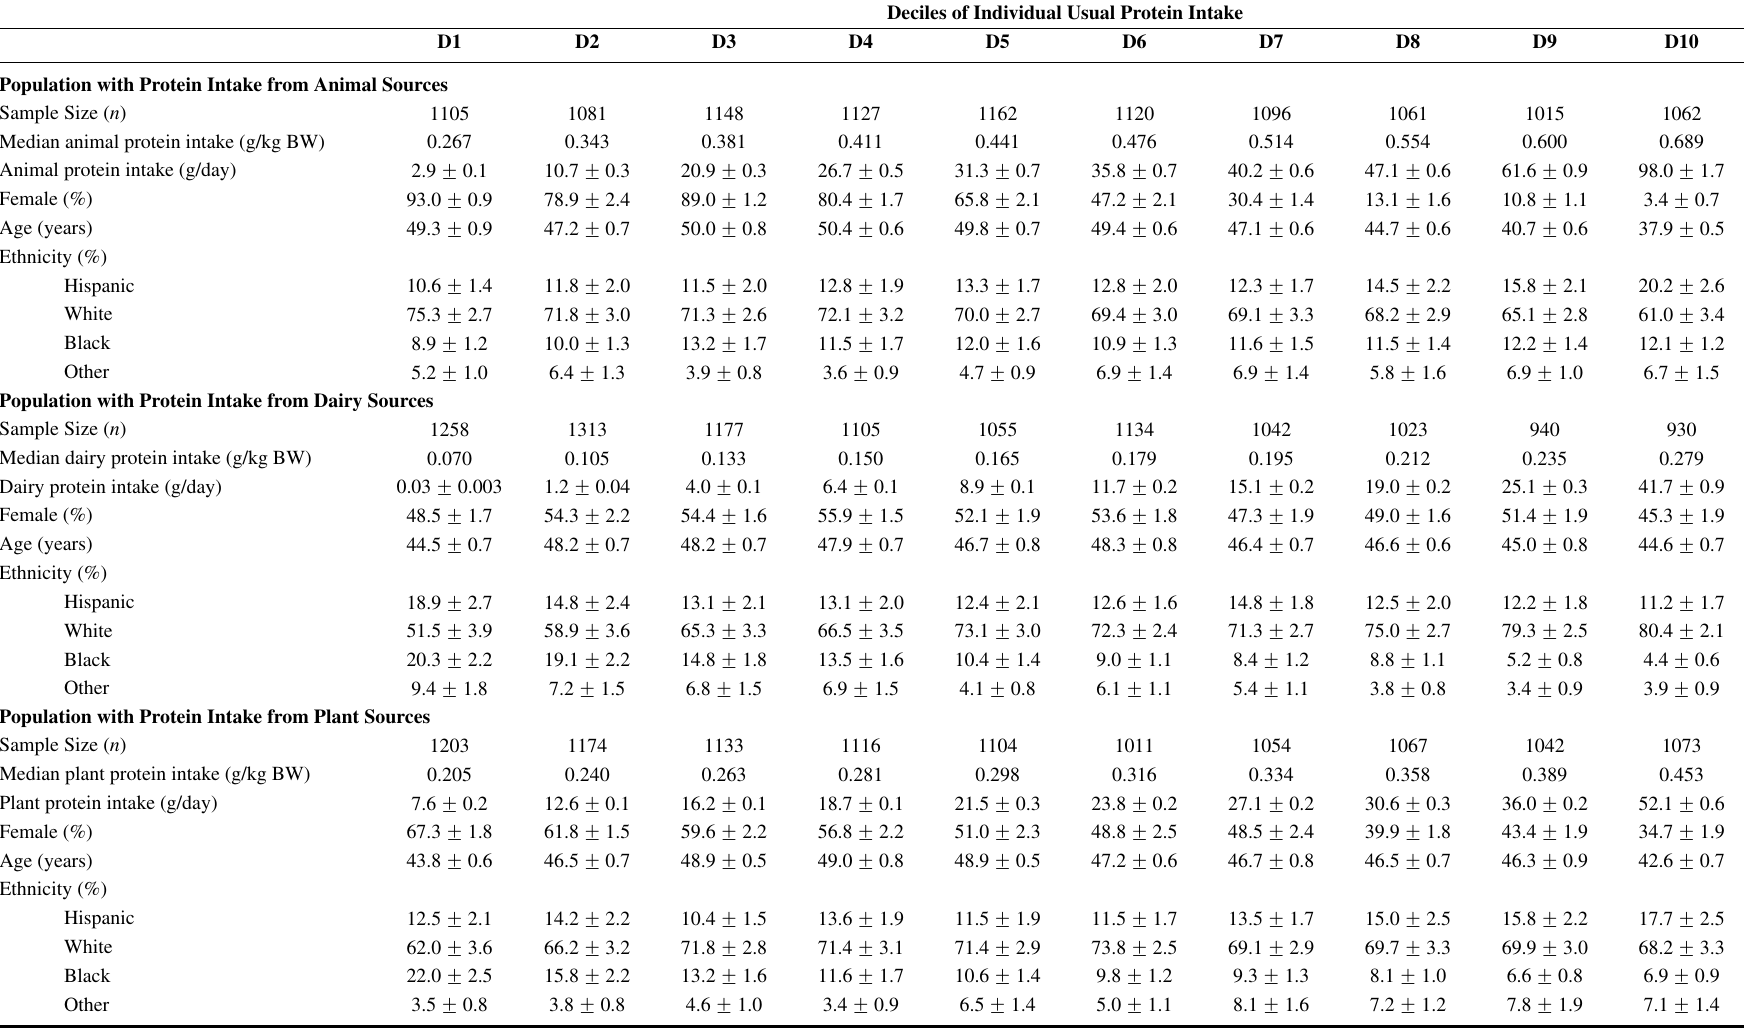
Table 1. Demographics of US adults (age 19 years and older) according to absolute (g/day) and relative (g/kg BW) protein intake from different protein source types (NHANES